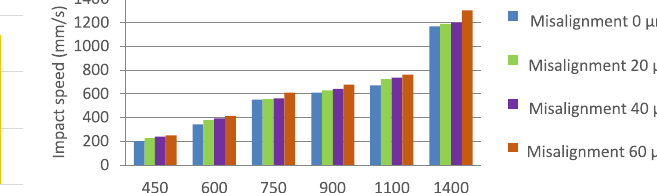
Fig. 9. Valve impact speed on the seat.